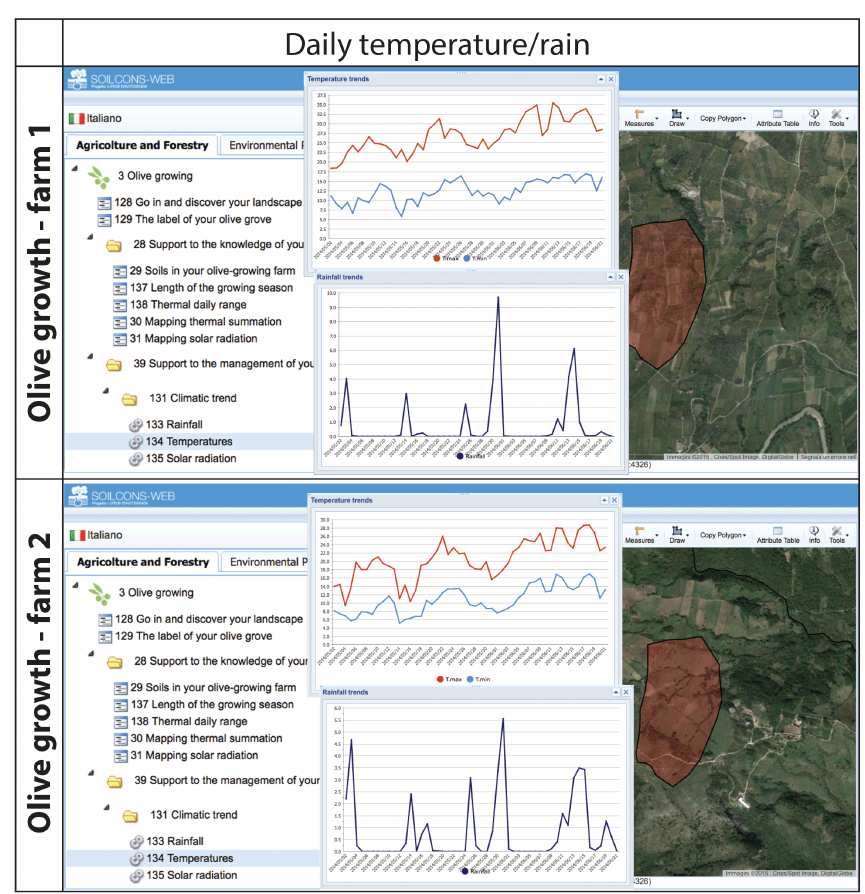
Figure 7. Output examples from the support for olive growth tool: climate